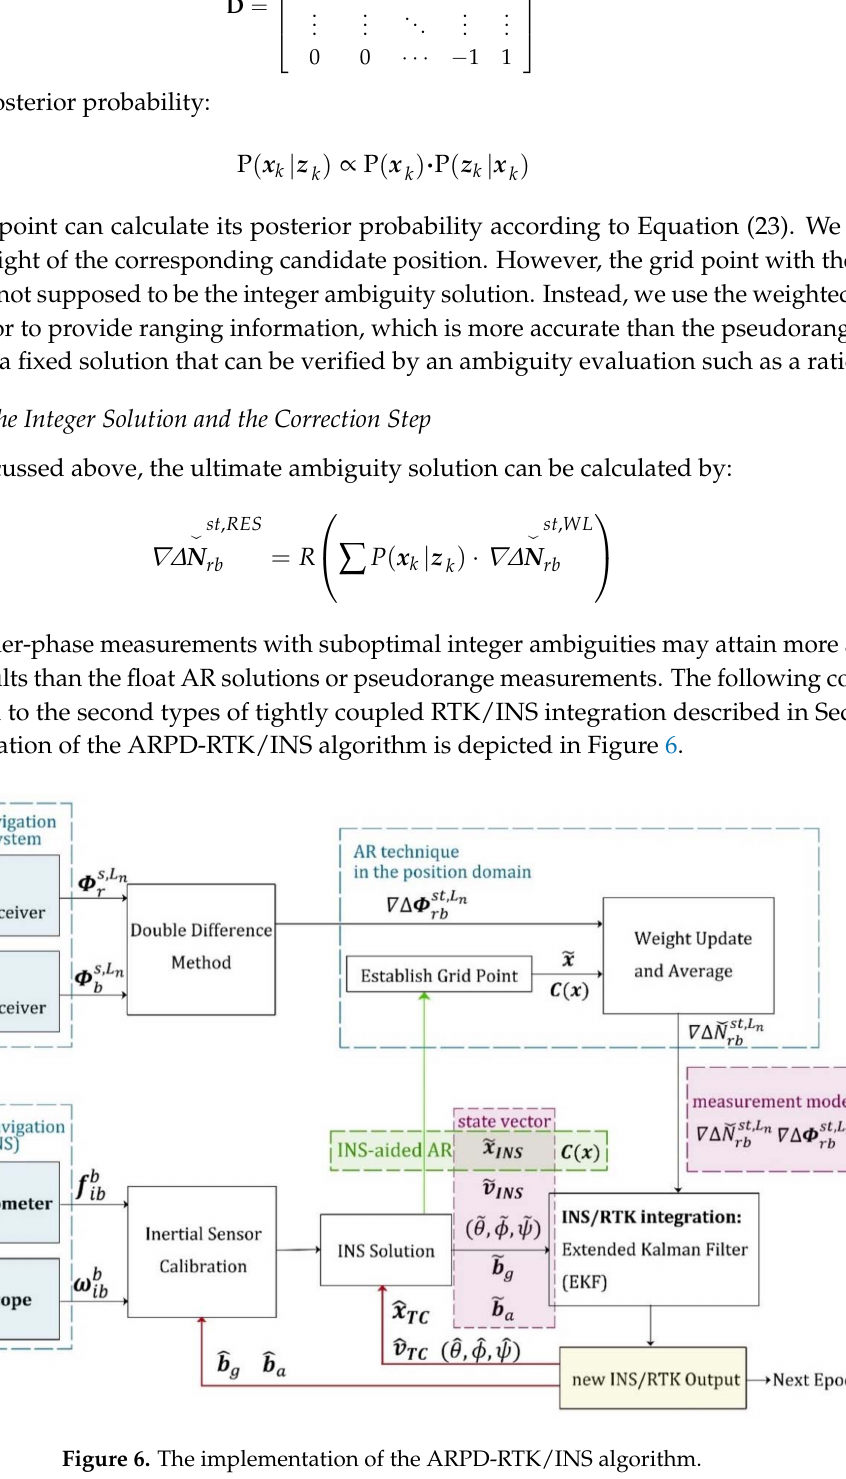
Figure 6. The implementation of the ARPD-RTK/INS